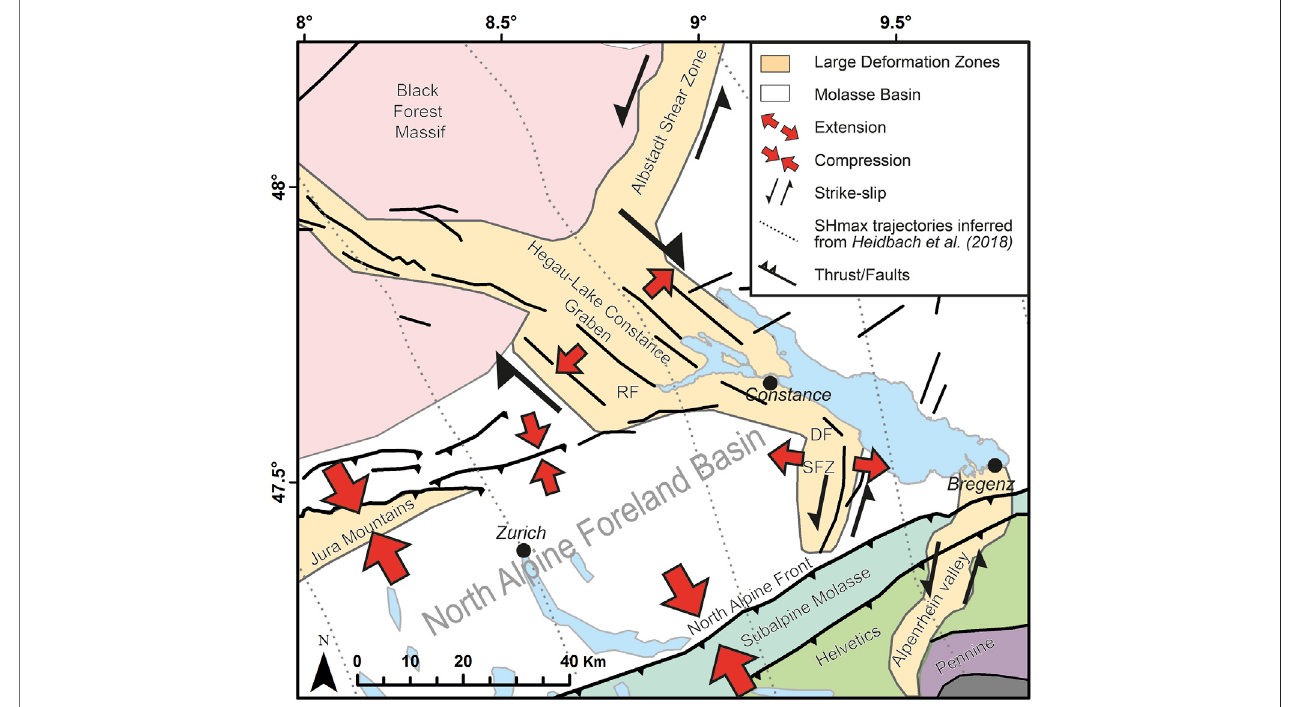
FIGURE 2| Simpli fi ed kinematic model for a selection of large-scaledeformation zones in the North Alpine Foreland Basin (modi fi ed after Egli et al., 2016 and Ring and Gerdes, 2016). Estimated maximum horizontal stress (SHmax) trajectories are inferred from Heidbach et al. (2018). DF: Dozwil Fault, RF: Randen Fault, SFZ: St. Gallen Fault Zone (also see Supplementary Table S1